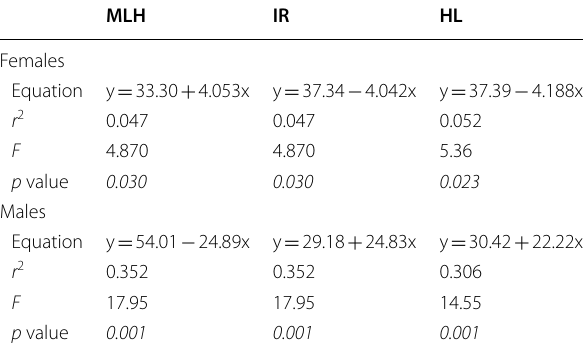
Table 3 Regression analysis of variance of carapace length against MLH, IR and HL for female and male N. norvegicus sampled individuals; significances are in italics MLH